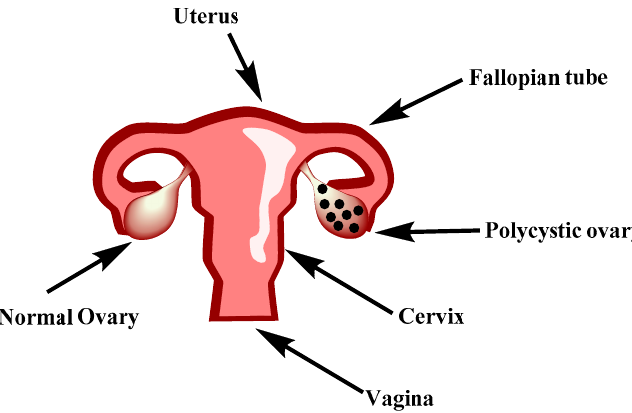
Figure 1. Differentiation between a normal and polycystic ovary.